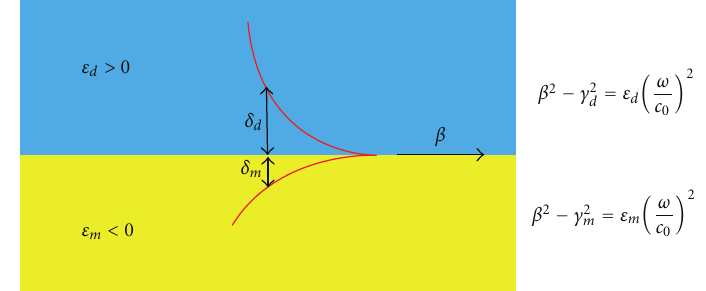
Figure 4: Definition of skin depths and their relation with propagation constant.